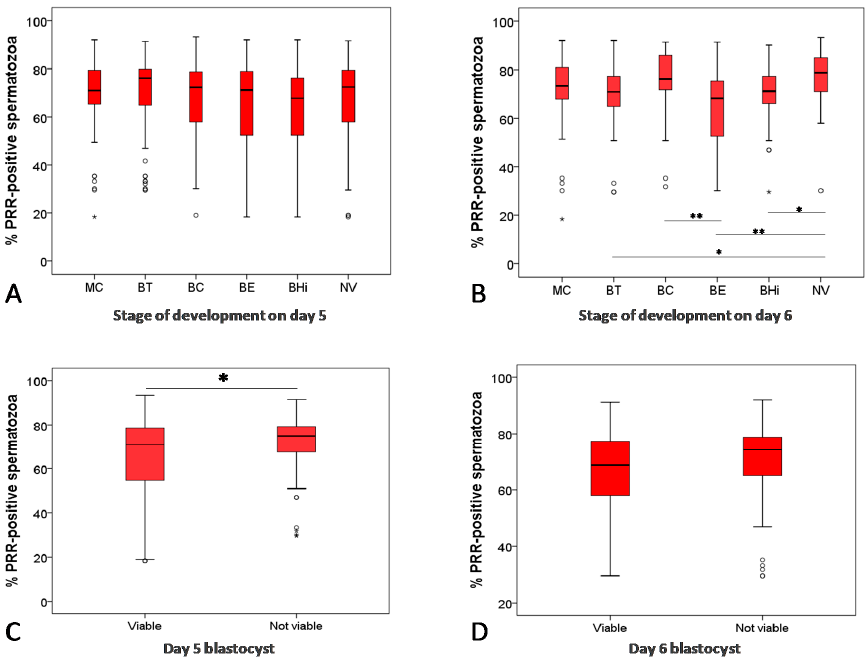
Figure 2. Graphic representation of the scoring and viability of the embryo on day 5 and day 6 and the association with the percentage of PRR-positive spermatozoa. Percentage of PRR-positive spermatozoa in association with the degree of development of the embryos on days 5 ( A ) and day 6 ( B ). Statistical differences among all groups were evaluated by using the Kruskall–Wallis test,